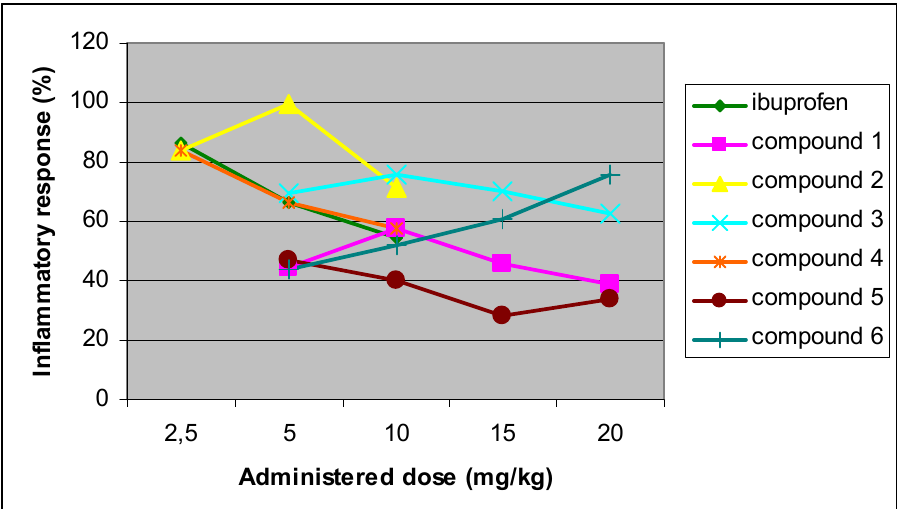
Figure 2. Dose dependence of anti-inflammatory effect of studied compounds listed on